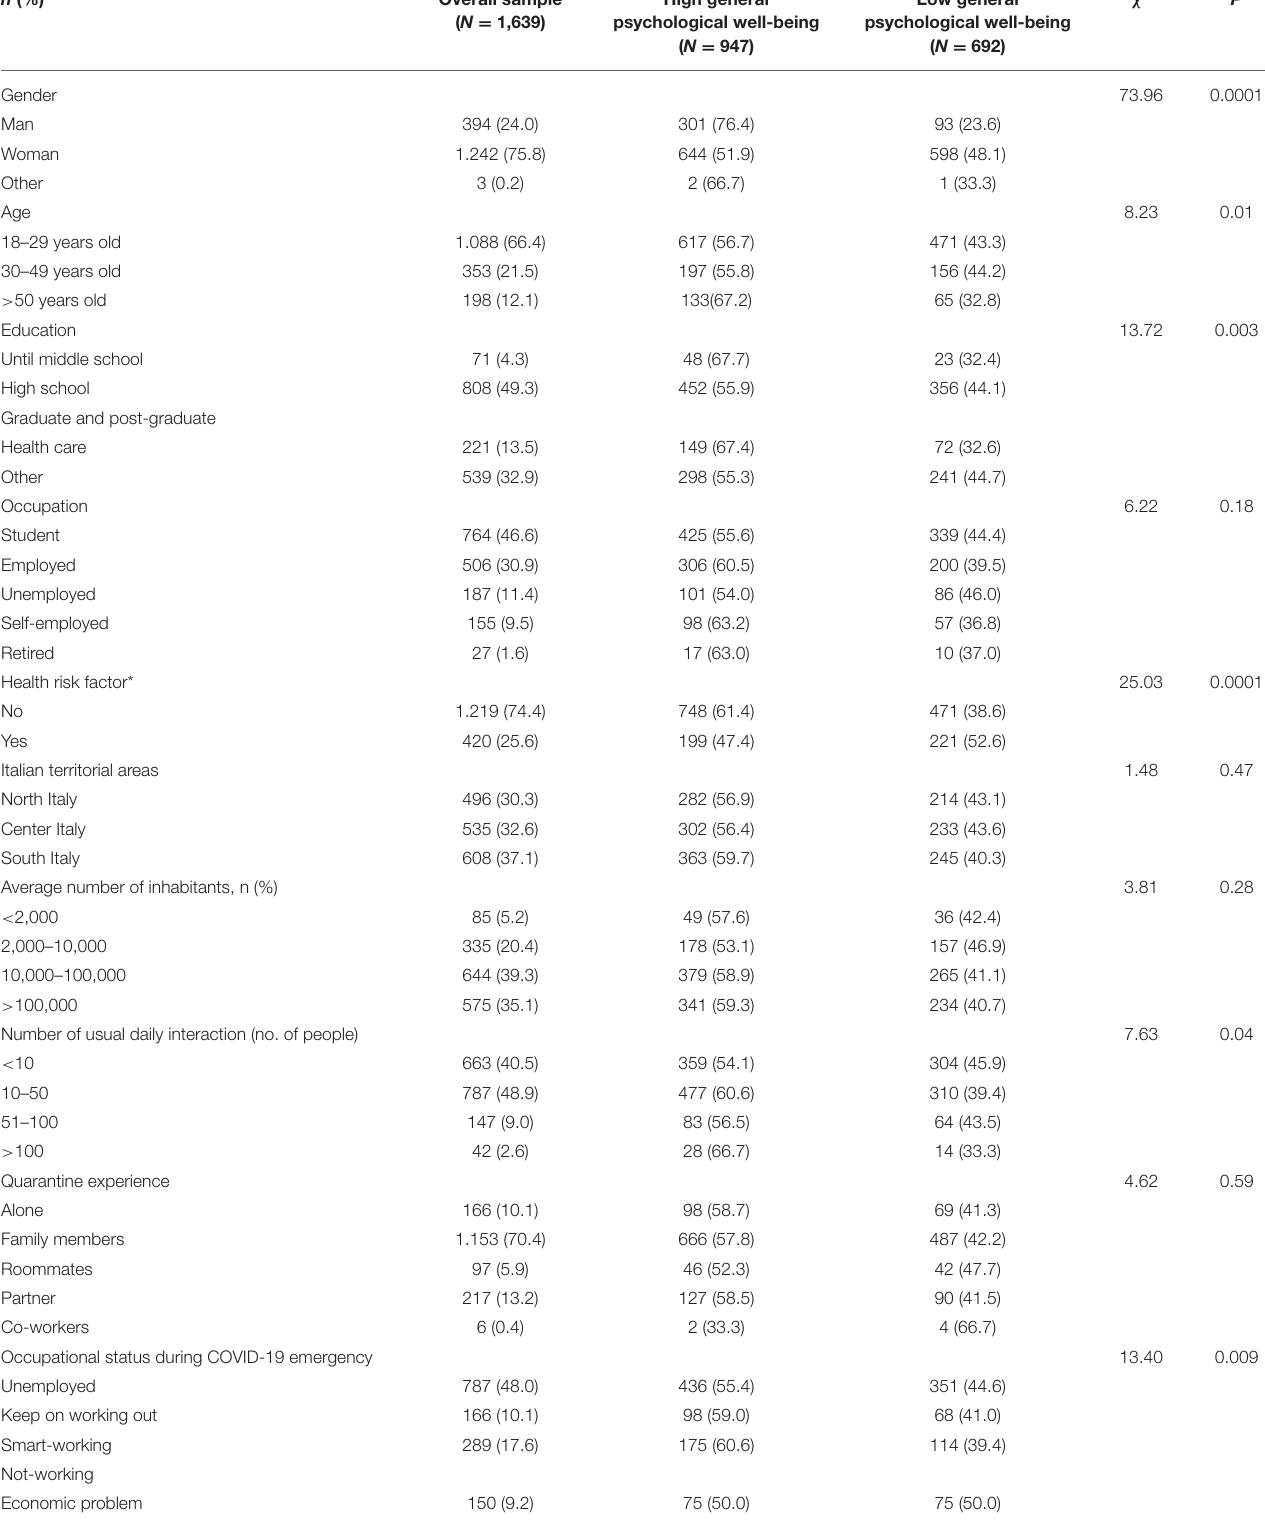
TABLE 1 | Demographic characteristics of the sample and information about